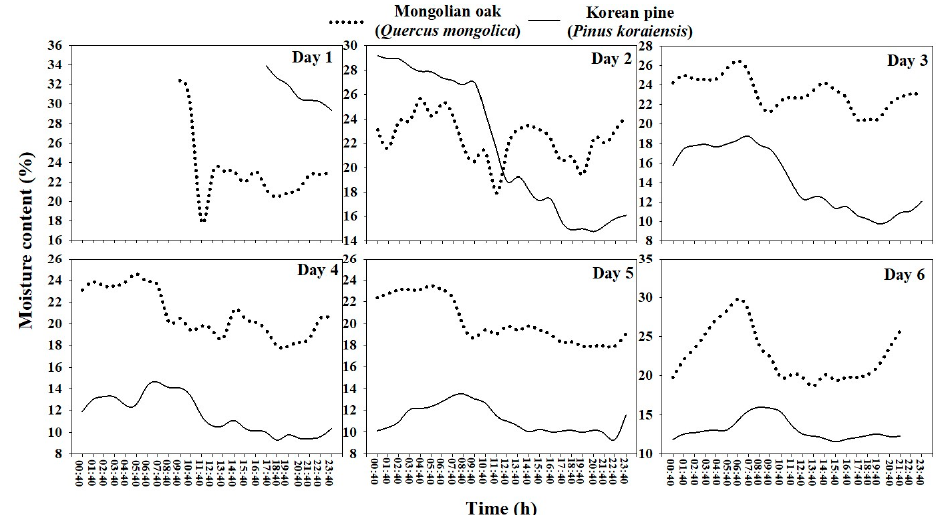
Figure 2. Diurnal variation of litter moisture contents of the Mongolian oak forest and Korean pine plantation.